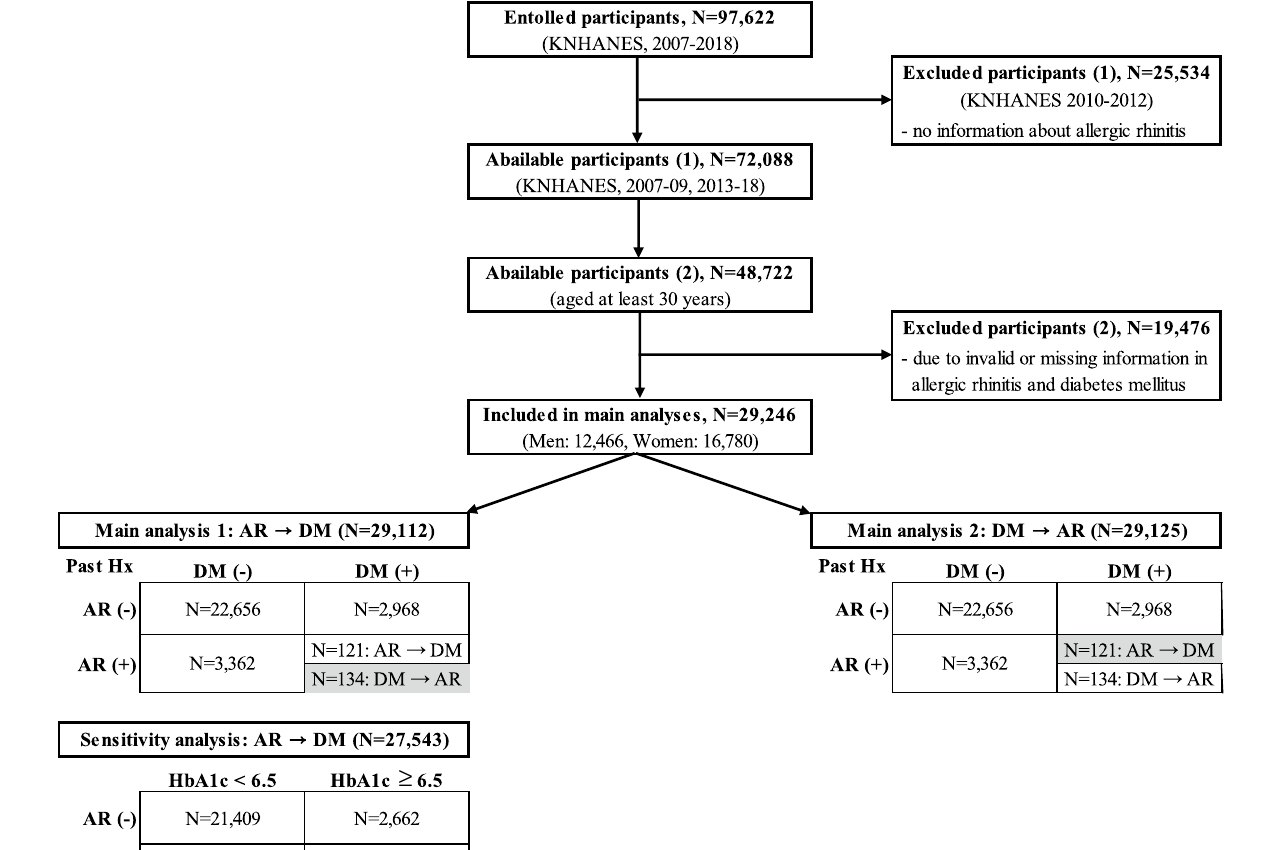
Figure 1. Flow chart of study participants. Sensitivity analysis, re-ran main analysis 1 by defining diabetes mellitus by HbA1c (cut-off: 6.5%). KNHANES Korea National Health and Nutrition Examination Survey, AR Allergic Rhinitis, DM Diabetes Mellitus, Hx history, HbA1c Hemoglobin